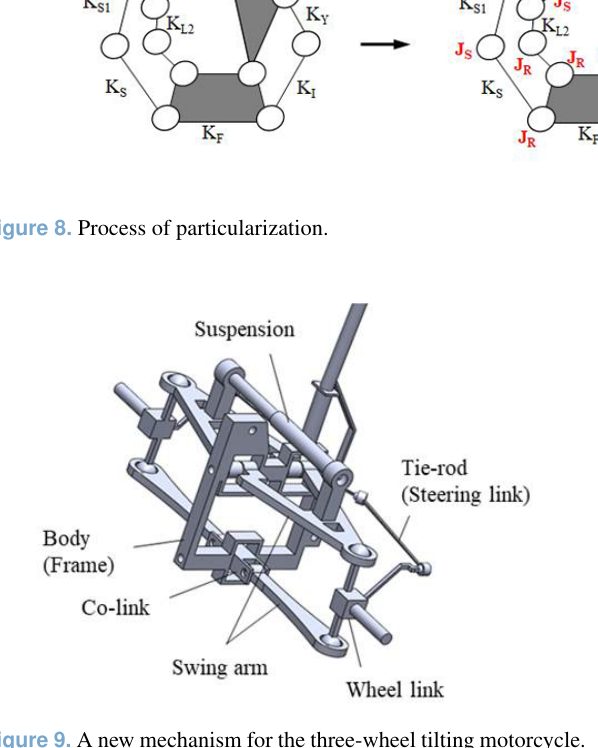
Figure 9. A new mechanism for the three-wheel tilting motorcycle.